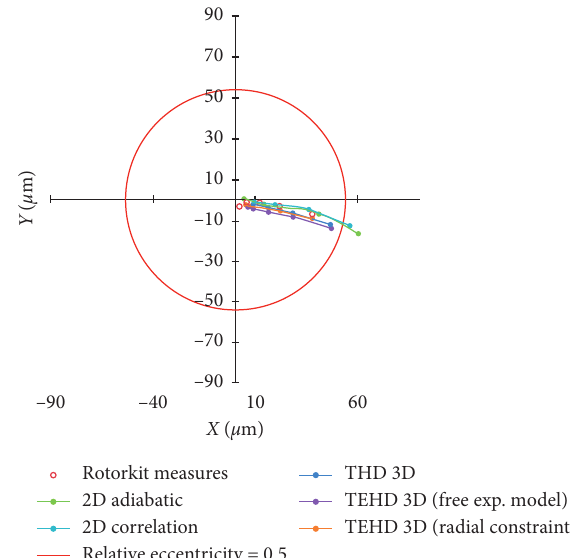
Figure 15: Mobility plot for the modified RK with respect to 3D numerical THD and TEHD simulation results in configuration 2.